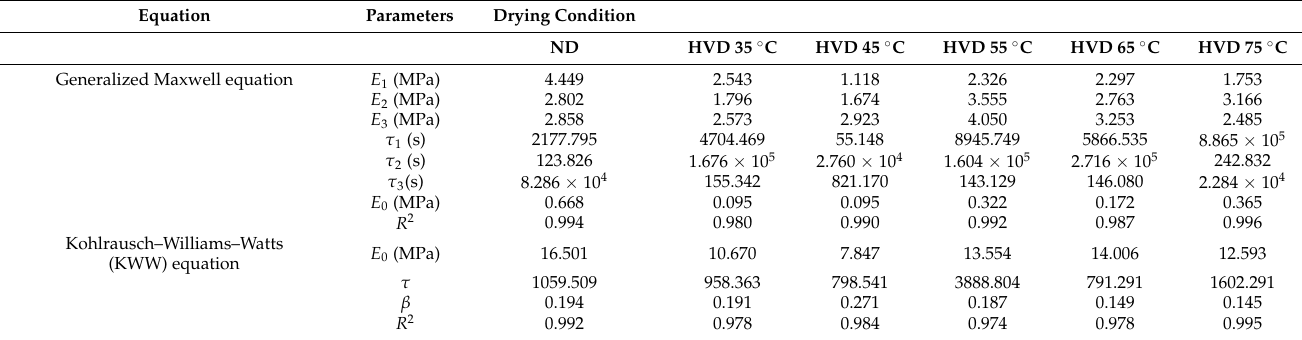
Table 5. Equation parameters for long-period stress relaxation of maize kernels.